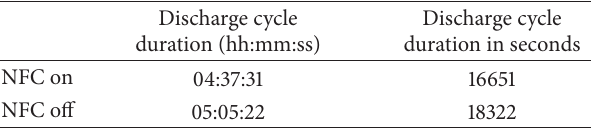
Table 5: Battery discharge cycle duration due to NFC